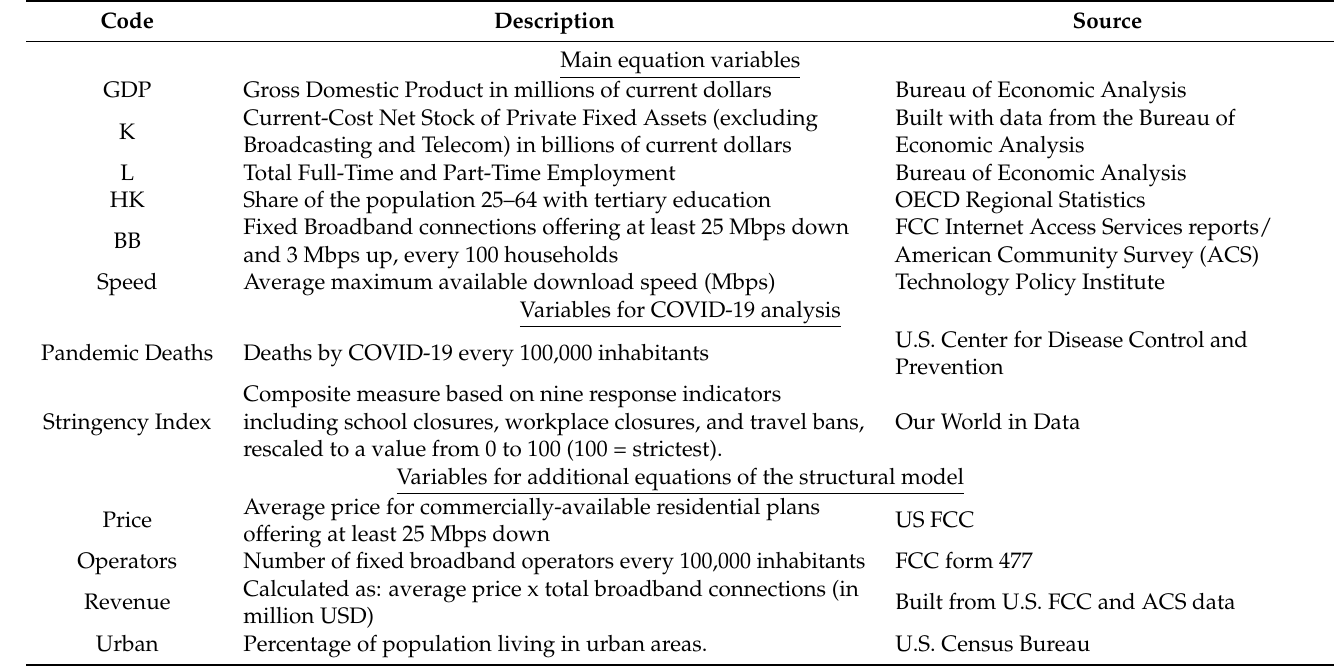
Table 2. Variables description and